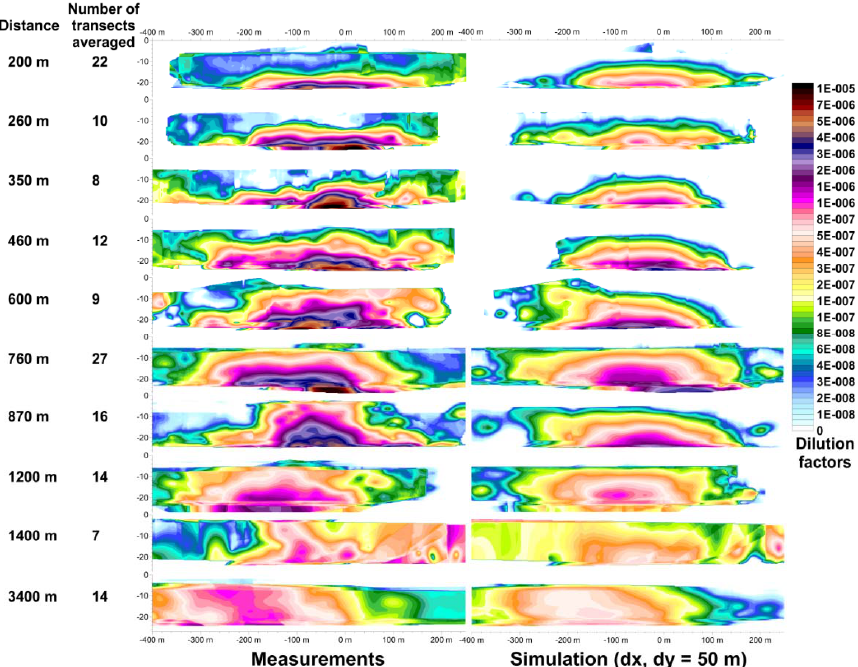
Figure 7. Variations with distance of the outfall of measured and simulated average dilution factors, adapted from [55].